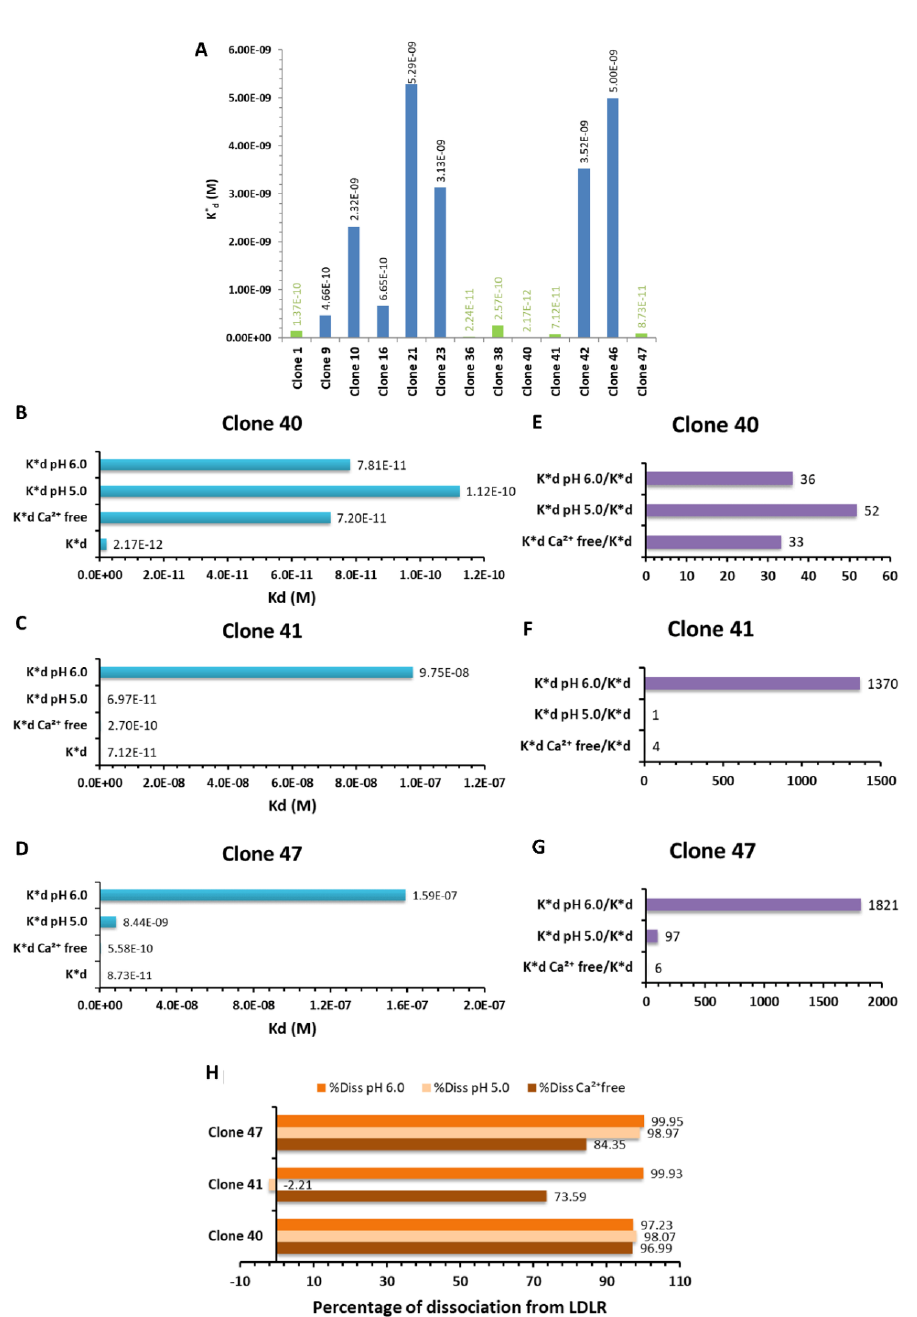
Figure 2. Binding of selected clones to ED-LDLR in various experimental conditions. ( A ) Apparent dissociation constants (K* d ) of the 13 representative clones selected from the phage display experiments. Clones with low K* d , revealing high affinities and selected for further characterization, are in green. ( B – D ) K* d of the clones 40, 41, and 47 in normal conditions, at acidic pH (pH 6.0, pH 5.0), and in the absence of calcium (Ca 2+ free). ( E – G ) Ratios between K* d in modified conditions and K* d of the clones, reflecting the inhibitory effects of these modifications on the clones binding. ( H ) Percentage of dissociation of the clones from the LDLR.